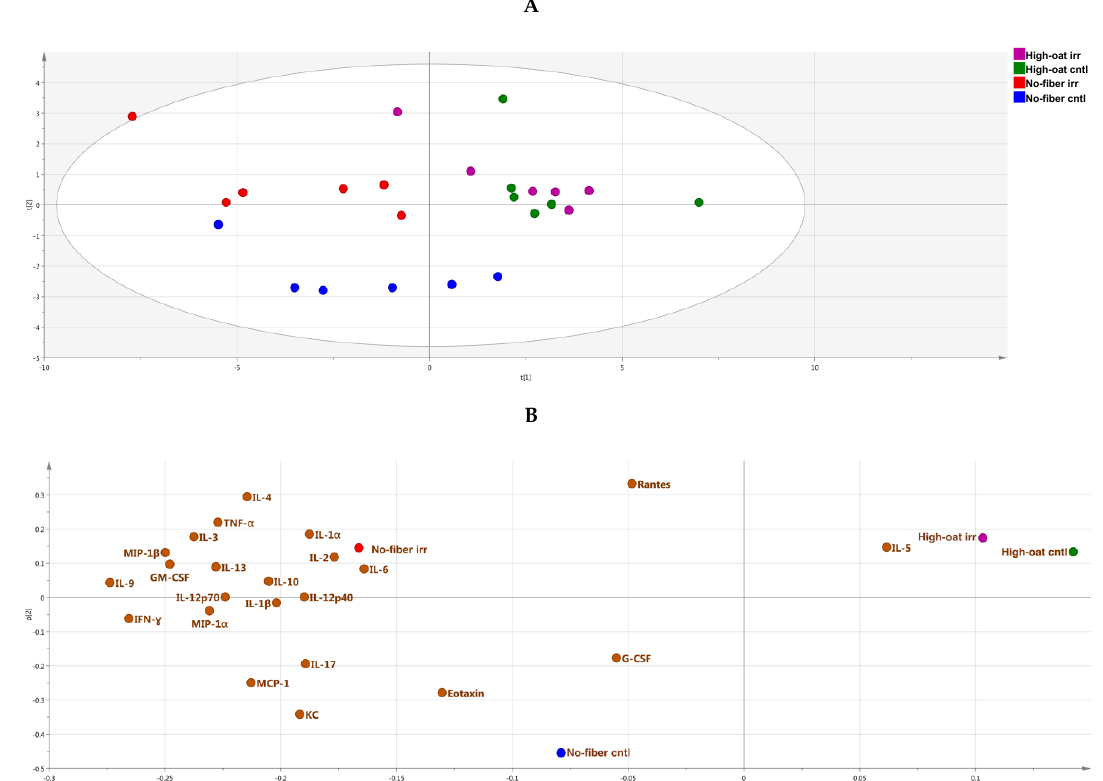
Figure 7. PCA analysis of serum cytokines and chemokines levels in mice at 18 weeks post-irradiation. ( A ) PCA score scatter plot of cytokine profiles, showing discrimination between the groups. ( B ) PCA loading scatter plot showing the associations between the cytokines and different groups.